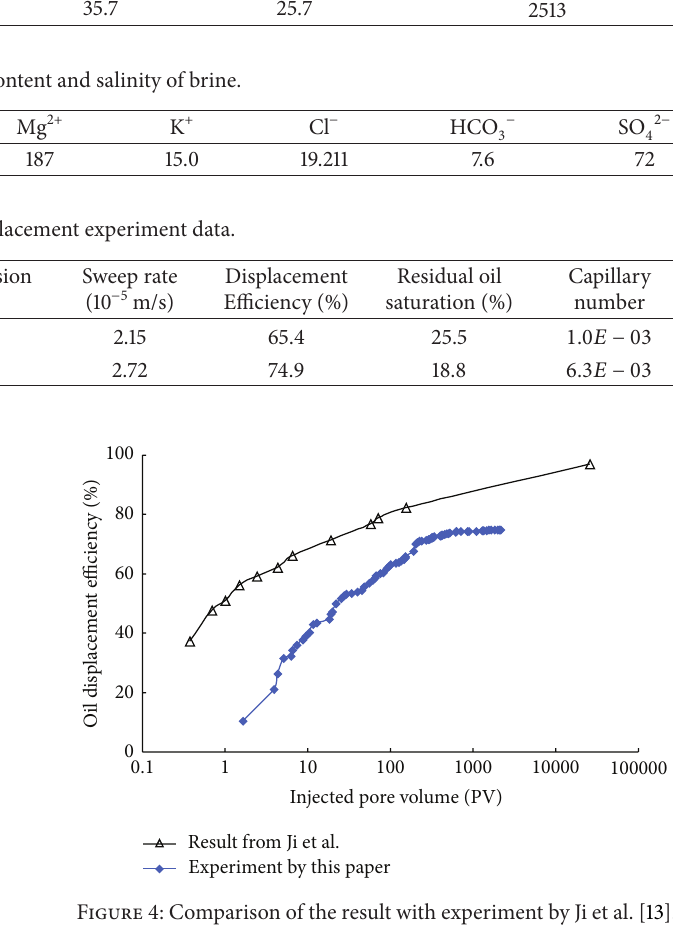
of oil and water were recorded (Table